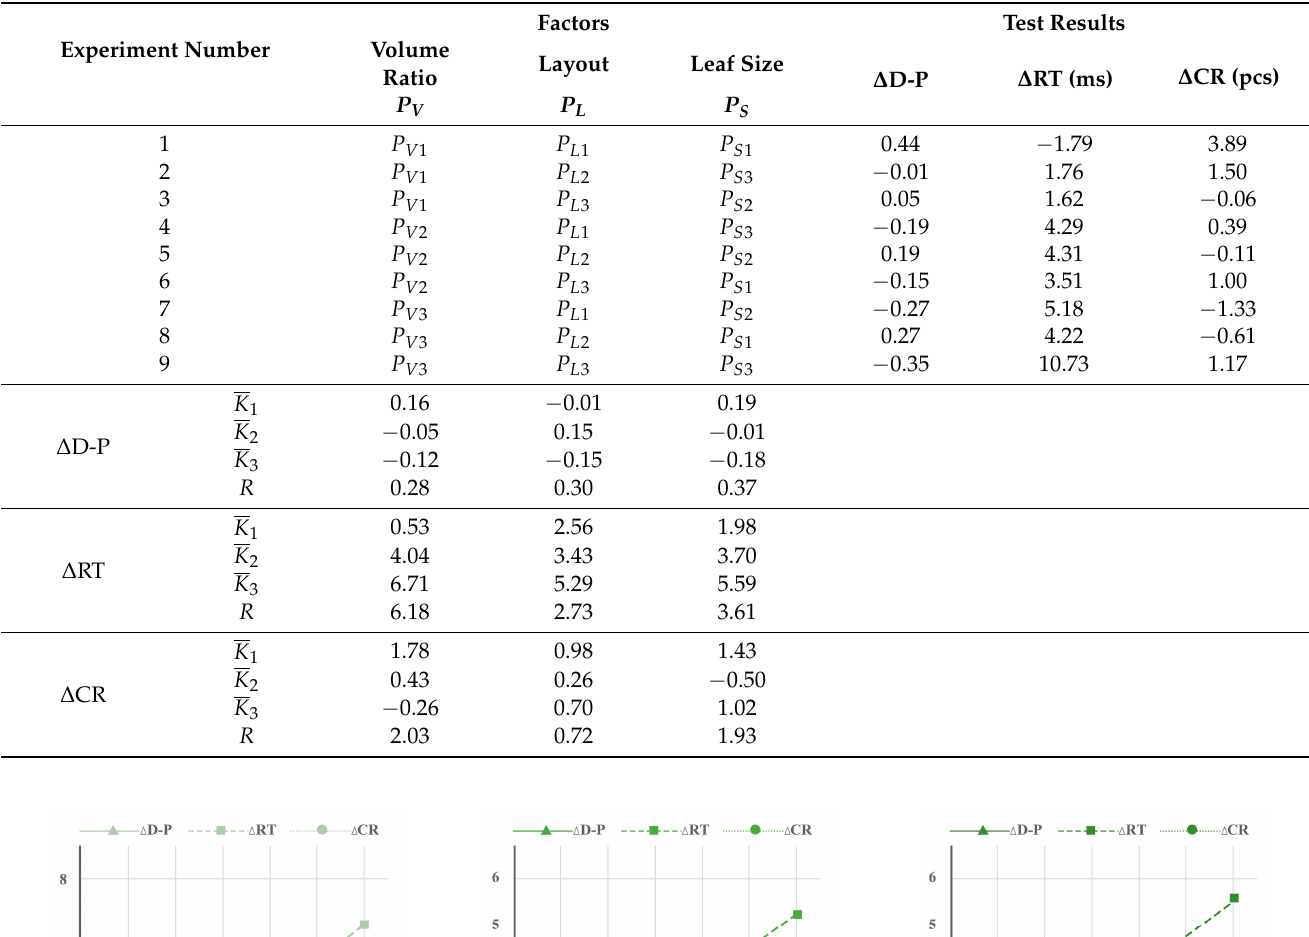
Table 4. Results and range analysis of the orthogonal experiments.